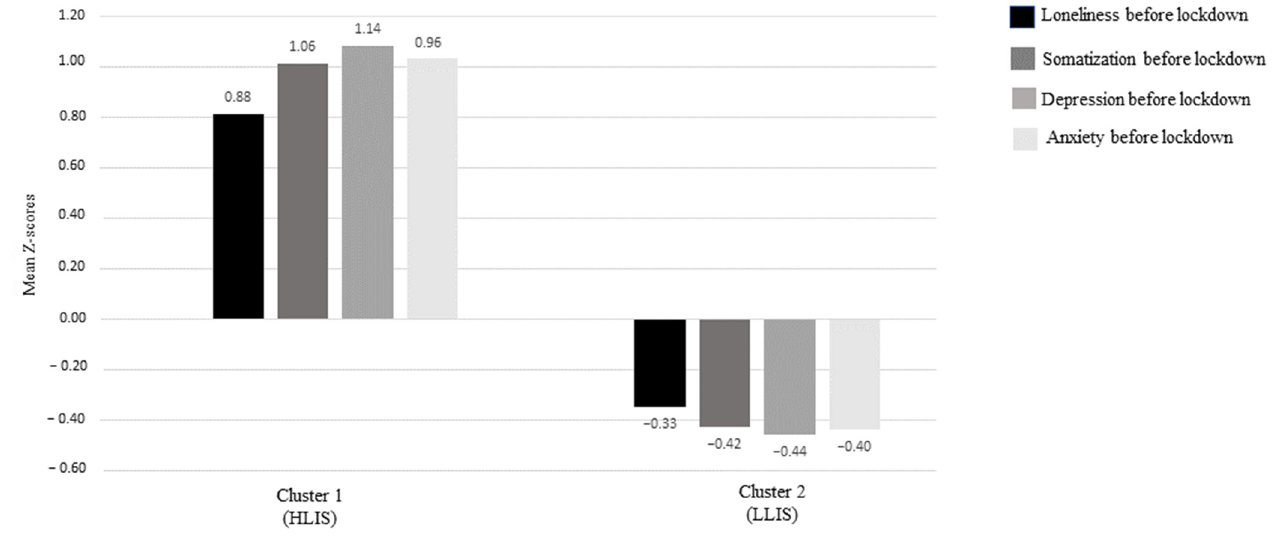
Figure 1. Profiles and z-scores for the clusters.